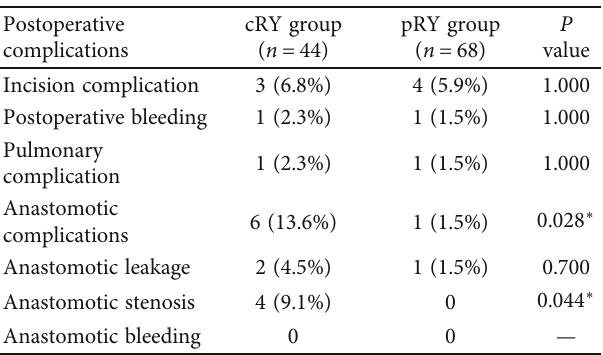
Table 3: Postoperative complications in the cRY group and the pRY